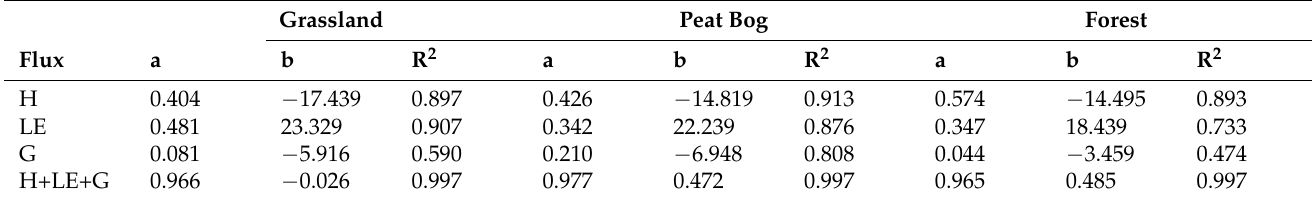
Table 2. Summary of linear regression between R n and H, LE, G, and H+LE+G for the grassland, peat bog, and forest sites. Y = aX + b; X is R n ; Y is H, LE, and so on. Peat Bog